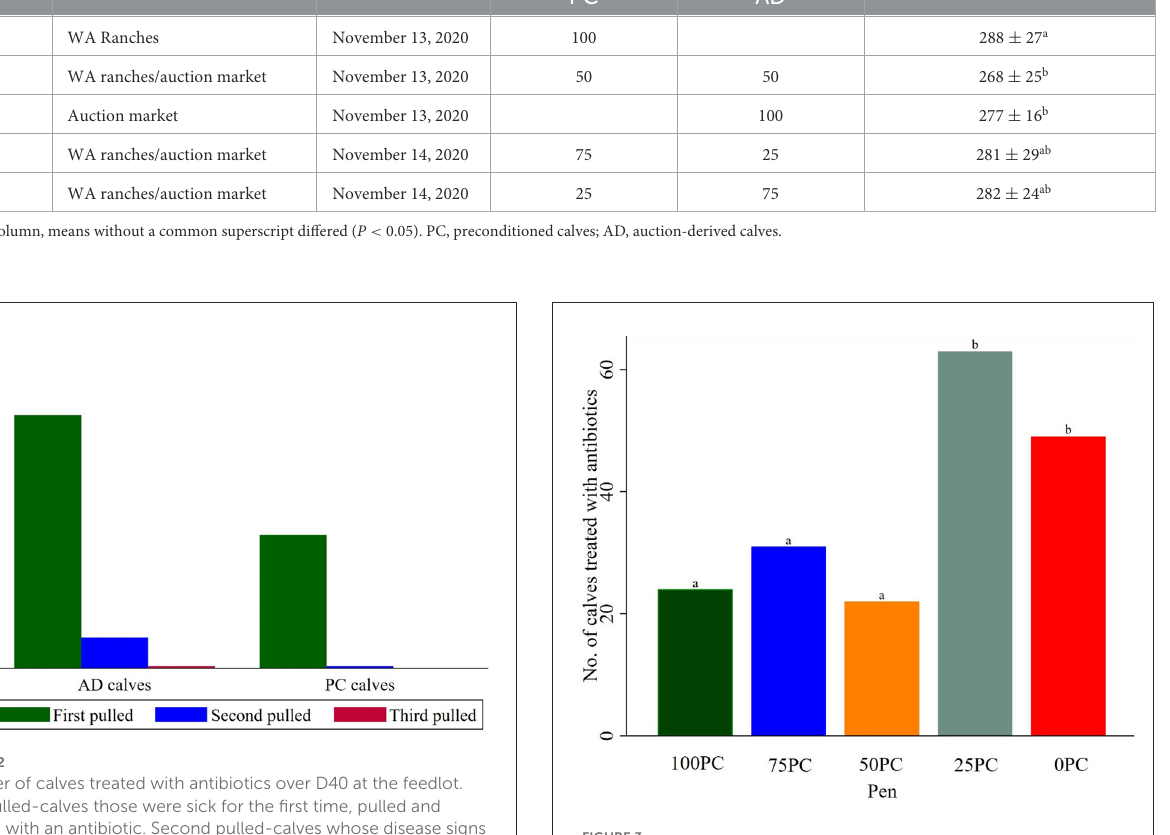
FIGURE3 Number of calves ( n = 190) treated in pens irrespective of source. PC reflects number of preconditioned calves among a group of 100. ab Counts without a common superscript differed ( P <